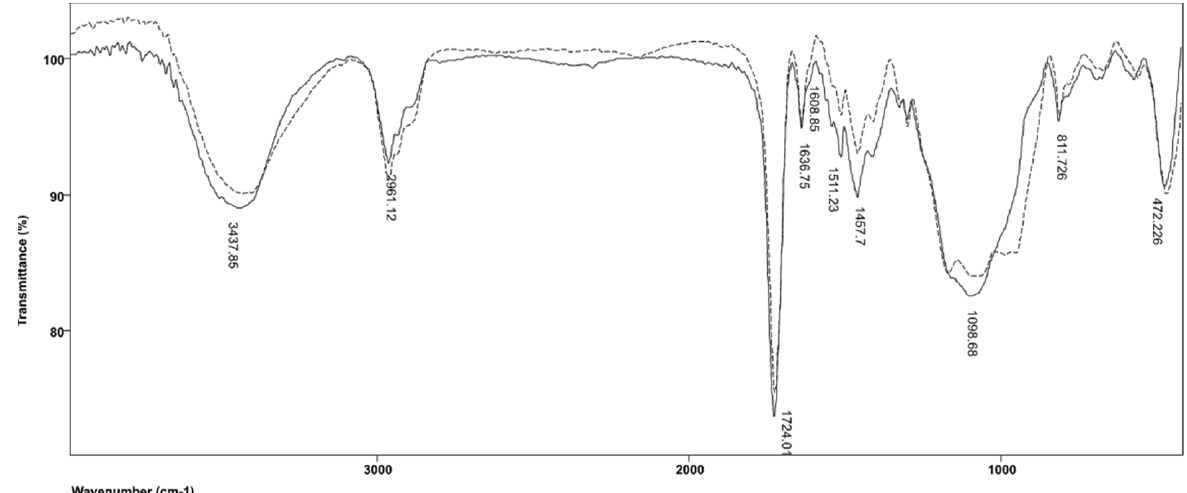
Figure 2. FTIR spectrum produced by the Maxcem Elite resin before and after polymerization.